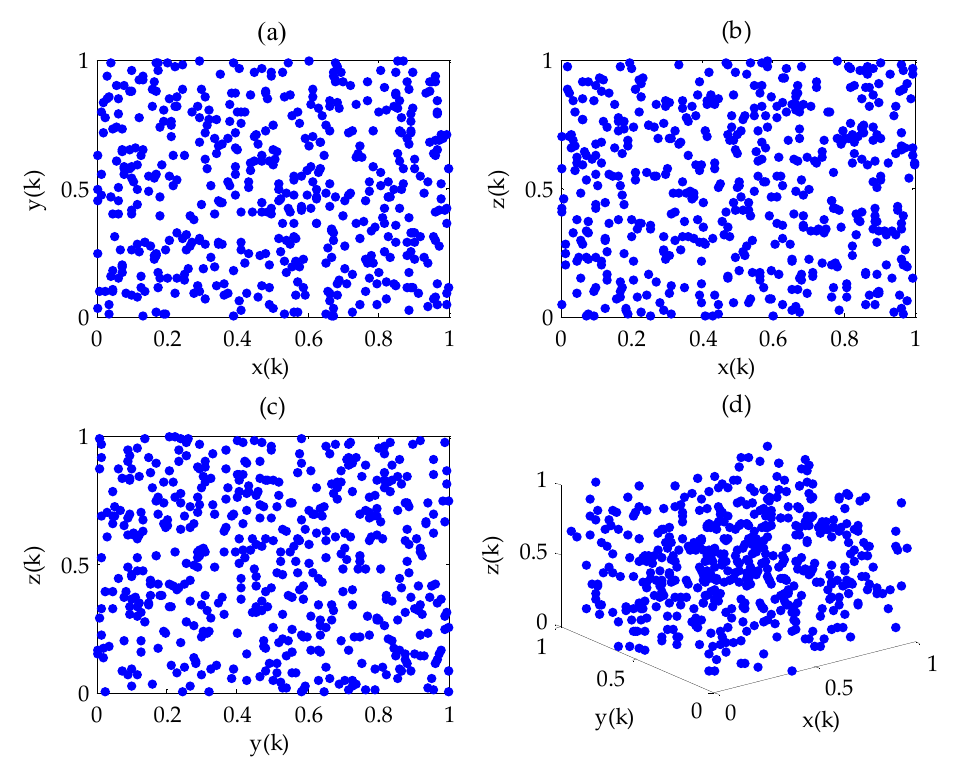
Figure 1. Phase diagram of system (2): ( a ) X–Y phase diagram; ( b ) X–Z phase diagram; ( c ) Y–Z phase diagram; ( d ) X–Y–Z phase diagram.